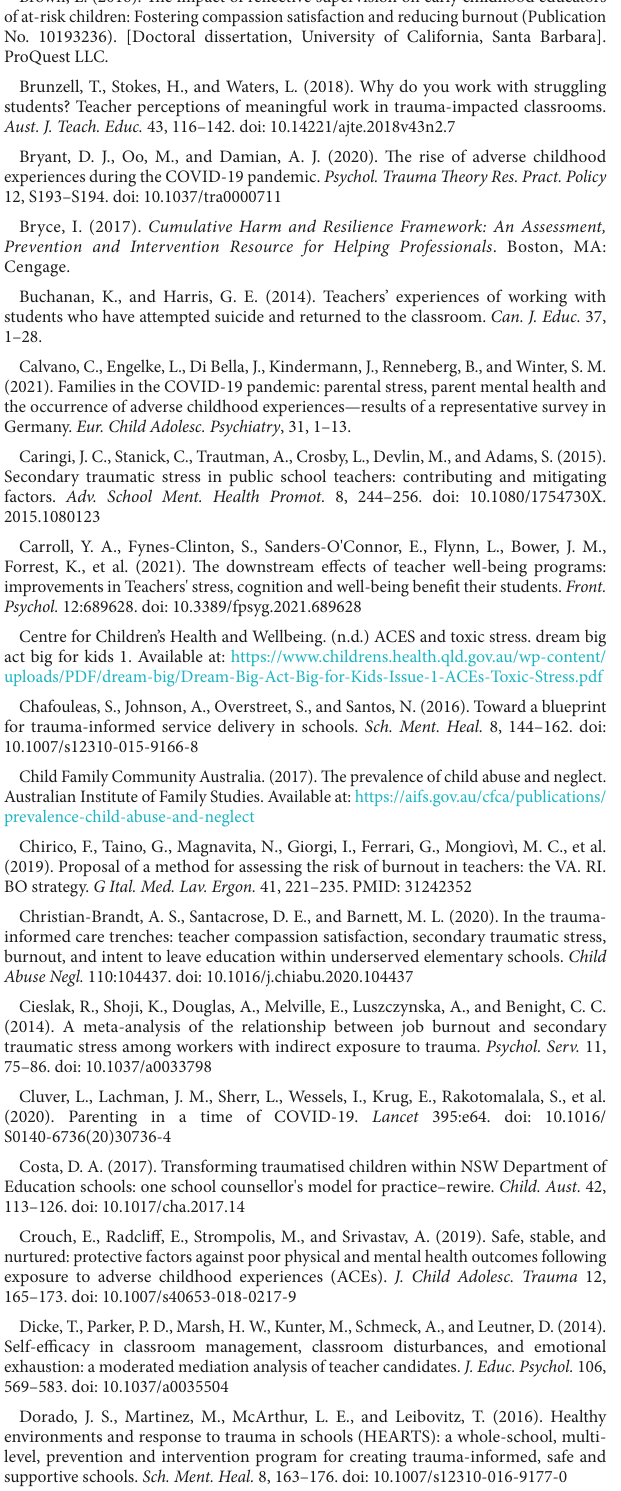
Figley, C. R. (2013). Compassion Fatigue: Coping With Secondary Traumatic Stress Disorder in Those Who Treat the Traumatized . Oxfordshire: Routledge. Figley, C. R. (1995). Compassion Fatigue: Toward a New Understanding of the Costs of Caring .